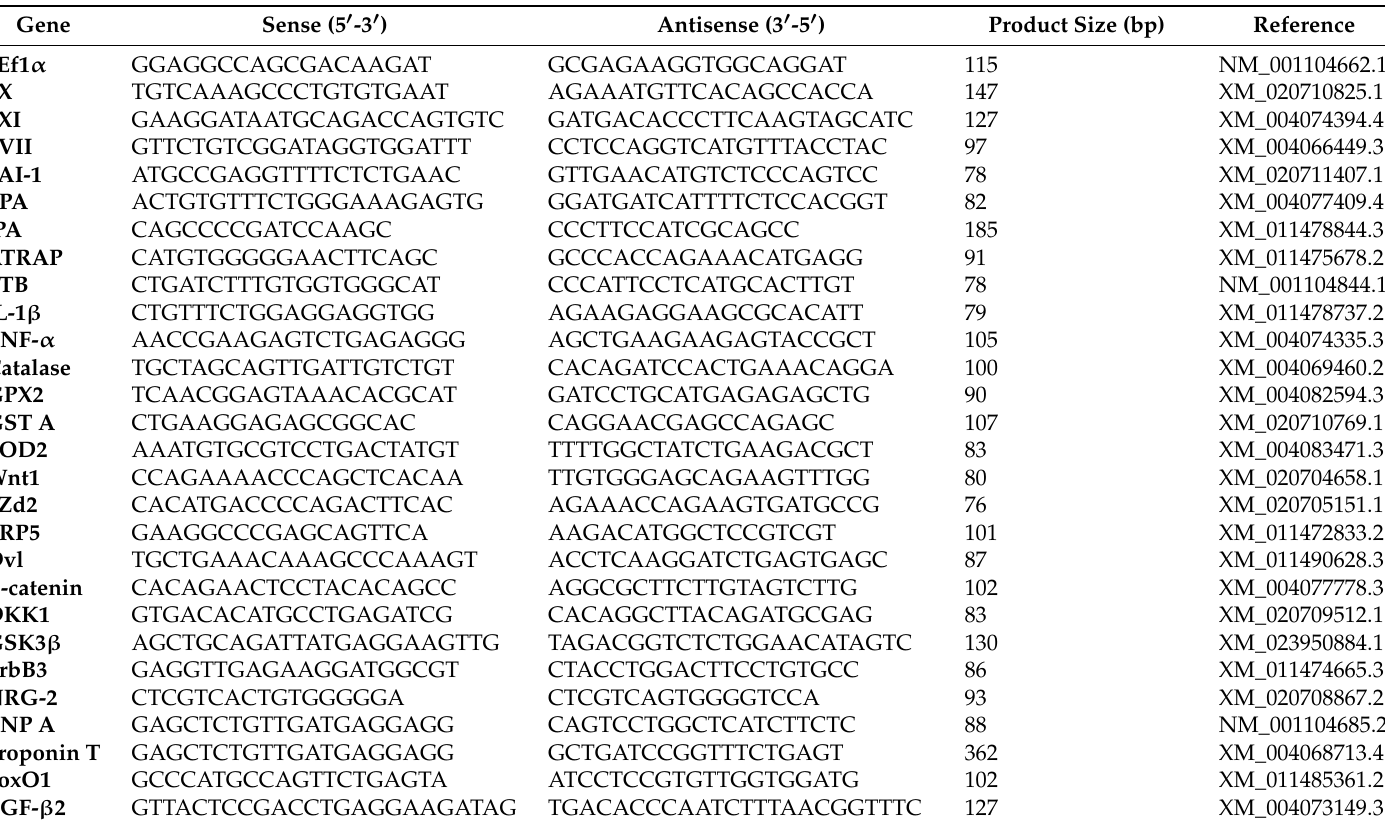
Table 1. Oligonucleotide sequences used in this